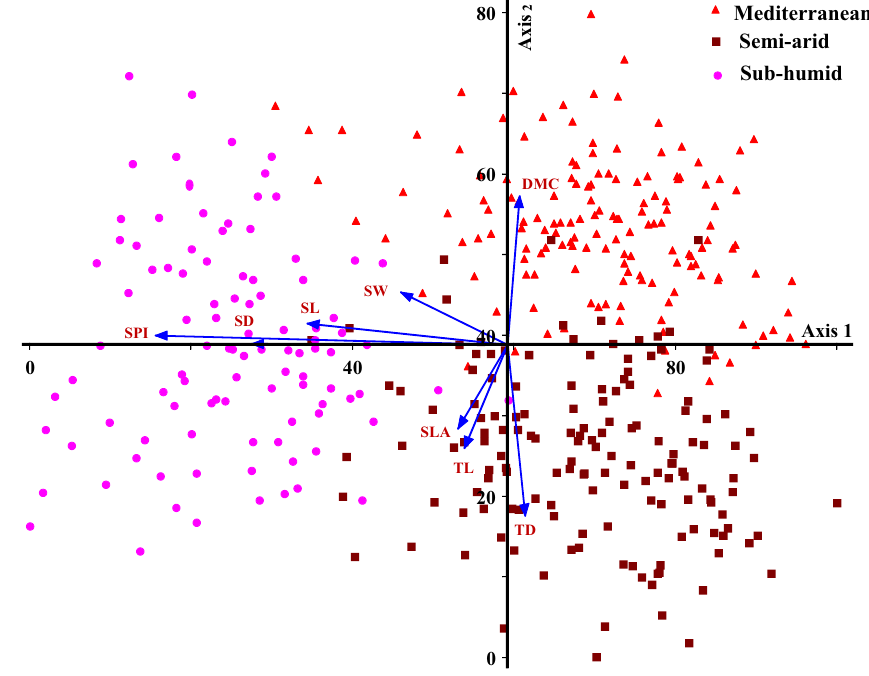
Figure 3. Biplot of principal component analysis (PCA) between Quercus brantii leaf morphological and anatomical traits in three different climates. Leaf length, (LL), specific leaf area (SLA), dry matter content (DMC); stomata length (SL), stomata width (SW), stomatal density (SD), stomatal pore index (SPI), trichome length (TL), trichome width (TW) and trichome density (TD).